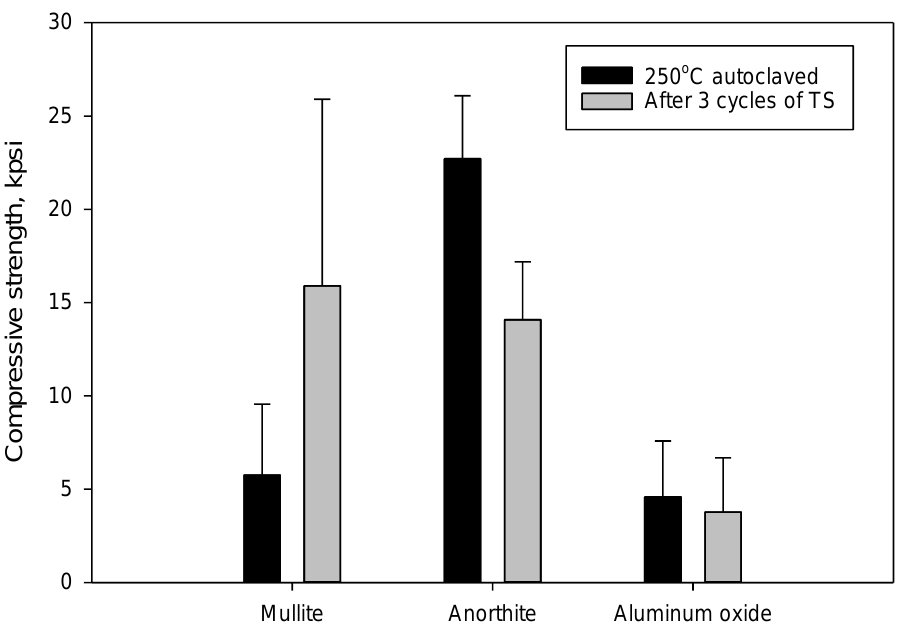
Figure 23. Compressive strength of 250 °C autoclaved samples and samples exposed to 3 cycles of thermal shock (one cycle: 600 °C heating overnight → cold water quenching for 10 min).